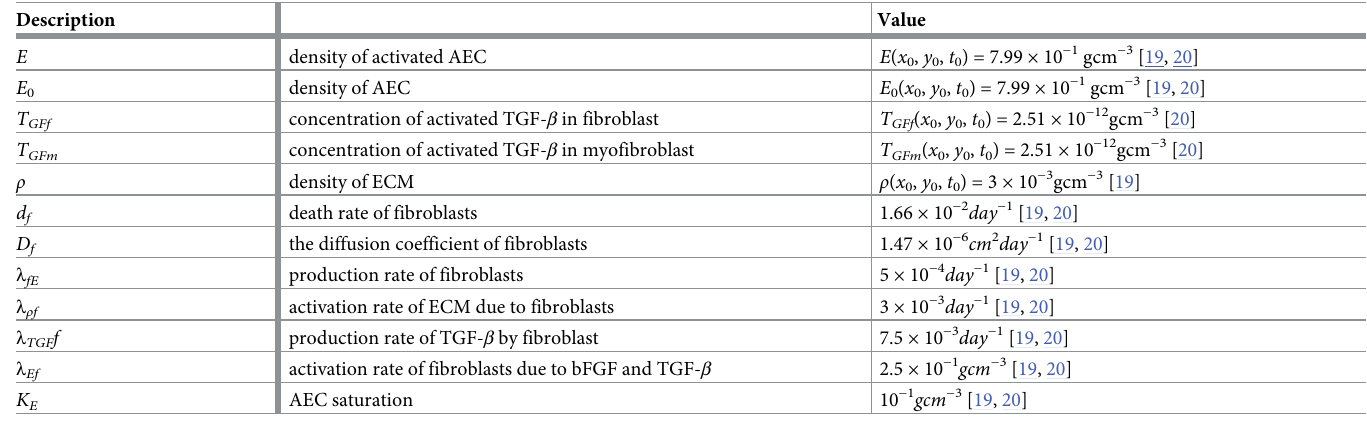
Table 2. Parameters’